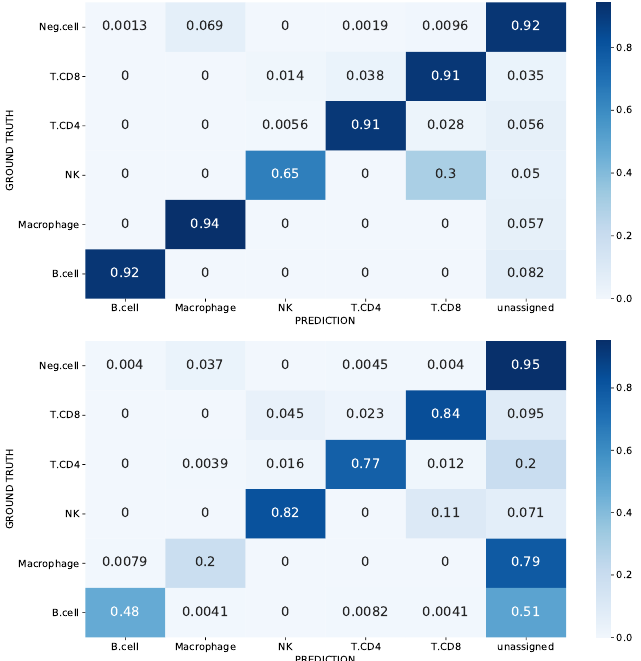
Figure 8. The confusion matrix of the melanoma dataset for the unknown cell-type identification task. SigPrimedNet (top) and Scibet